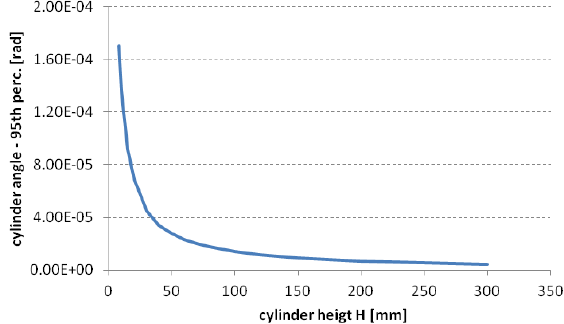
Fig. 5. Cylinder orientation uncertainty.